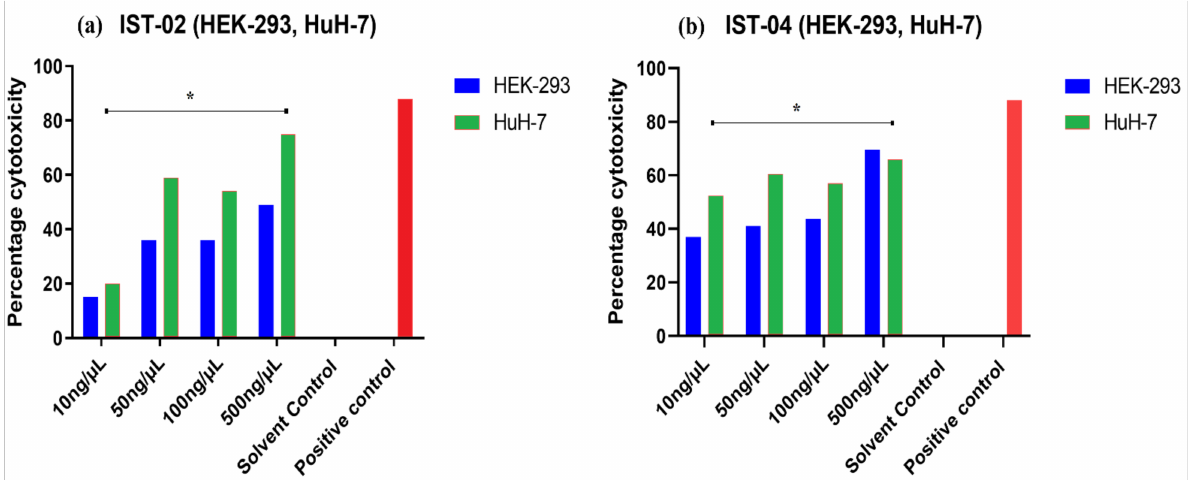
Figure 15. Percentage cytotoxicity of ( a ) IST-02 and ( b ) IST-04 at increasing concentrations on HuH-7 in comparison with HEK-293. The percentage cyotoxicity of the compounds was significantly greater for HuH-7 cells compared to HEK-293 ( p <